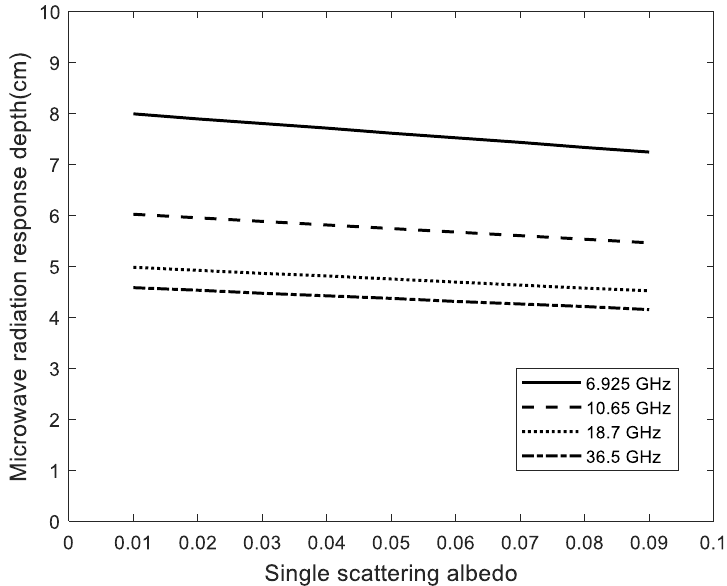
Figure 13. MRRD as a function of single scattering albedo at different frequencies.